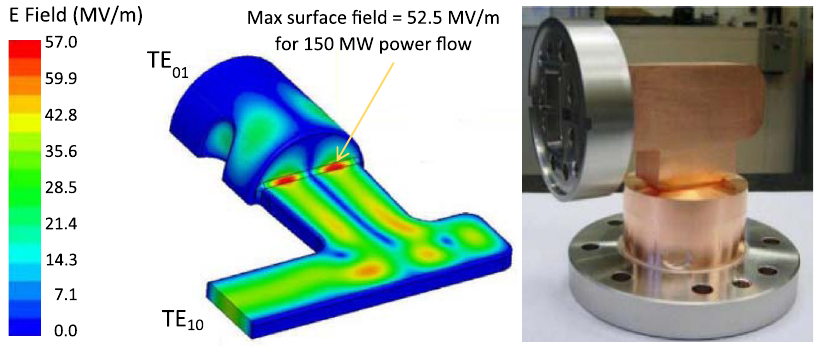
FIG. 4. (Left) Inner geometry and electric field of the mode launcher. (Right) Photograph of the compact mode